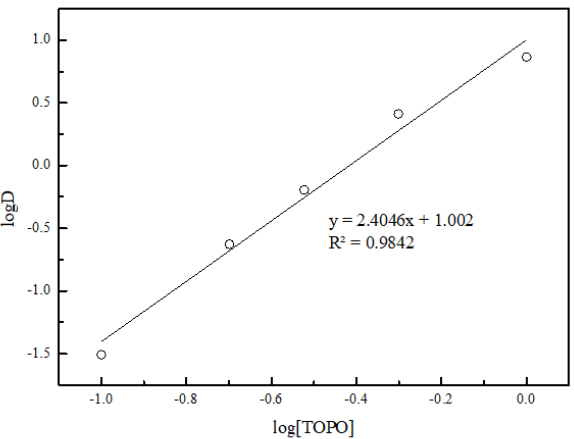
Figure 8. A plot of logD versus log[TOPO] for the extraction of Cu with TOPO. To investigate the dependence of Cu extraction on chloride ions, the Cl − concentration was varied by preparing various concentrations of NaCl (0.02 to 0.1 mol/L) with the same HCl concentration (3 mol/L) in the feed solution. With 1 mol/L TOPO, the